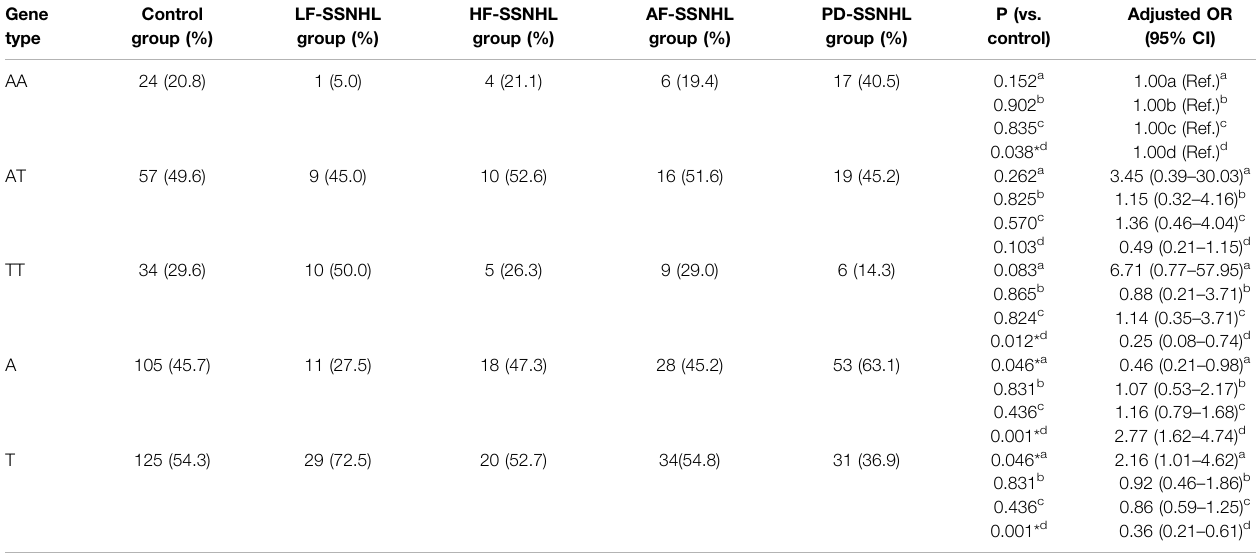
control group. * p < 0.05.